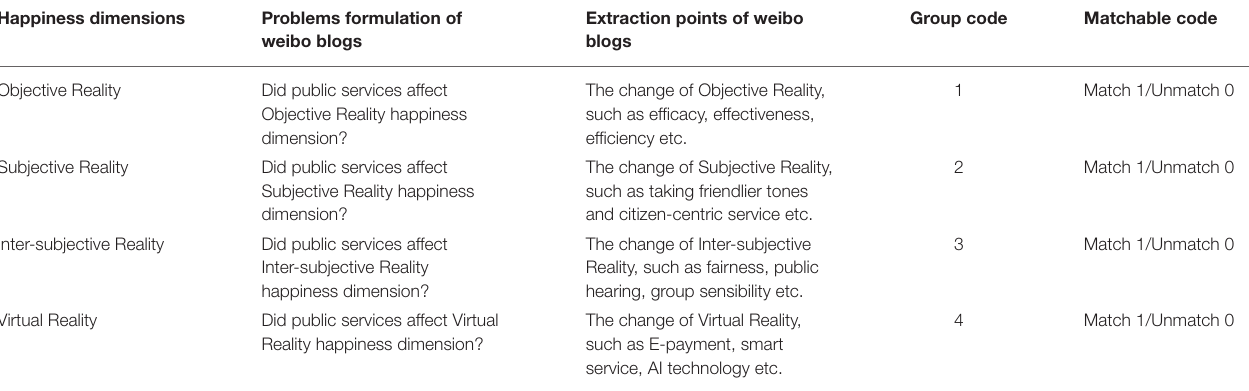
TABLE 2 | Quantification of the four happiness dimensions upon Weibo Blogs.